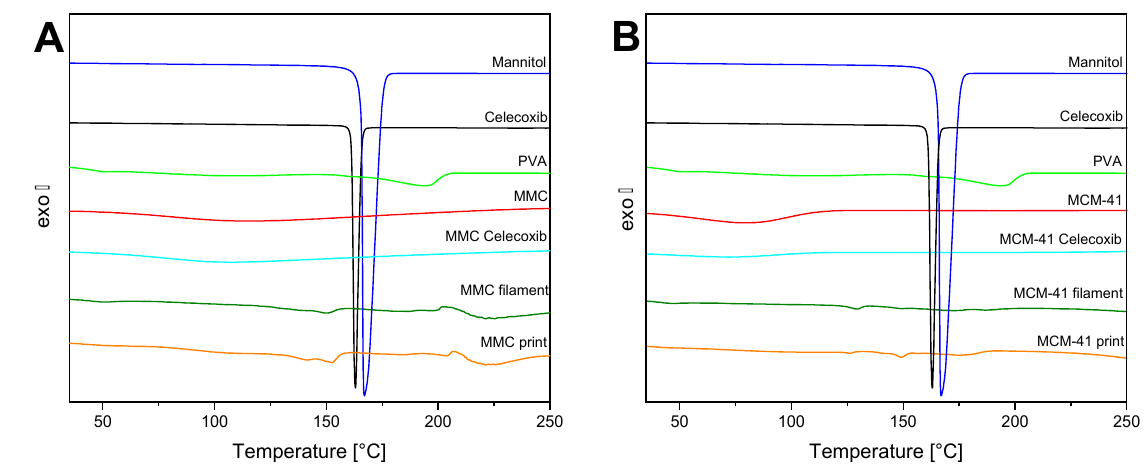
Figure 5. DSC thermograms of filaments, tablets, and individual components; ( A ) MMC-containing formulations; ( B ) MCM-41-containing formulations.